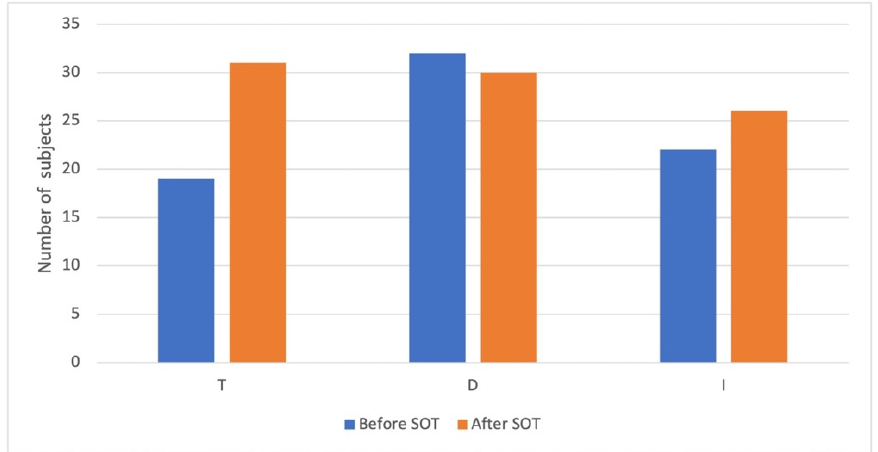
Figure 2. T, D and I before and after the olfactory training based on age- and sex-normalized val- ues.